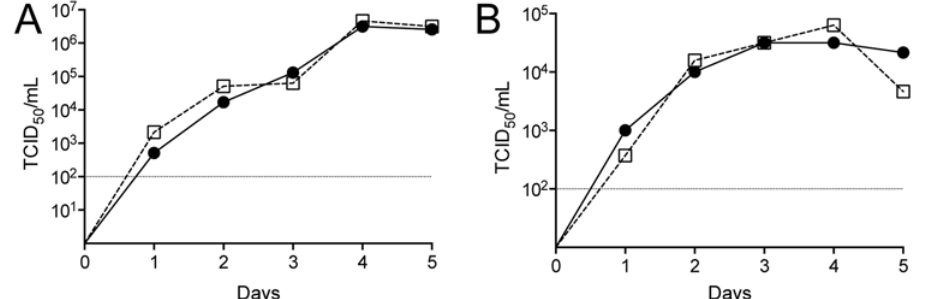
Fig 2. Growth kinetics of CCHFV derived from cDNA. (A) BSR-T7/5 and (B) A549 cells were infected with 0.001 of 50% tissue culture infective dose (TCID 50 )/cell of cDNA-derived CCHFV (circles) or parental virus isolate from Nigeria (squares). Viral titers were measured daily. Dashed line indicates the limit of